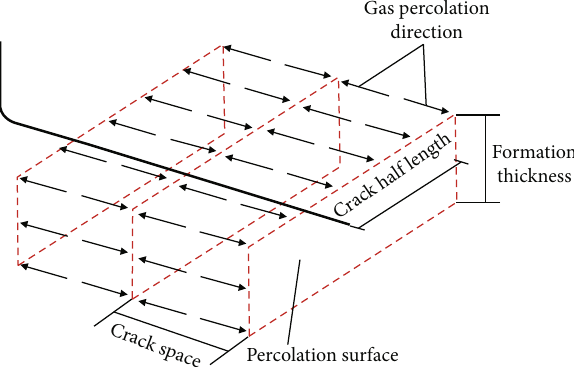
Figure 10: The fracturing fl ow fi eld in the horizontal